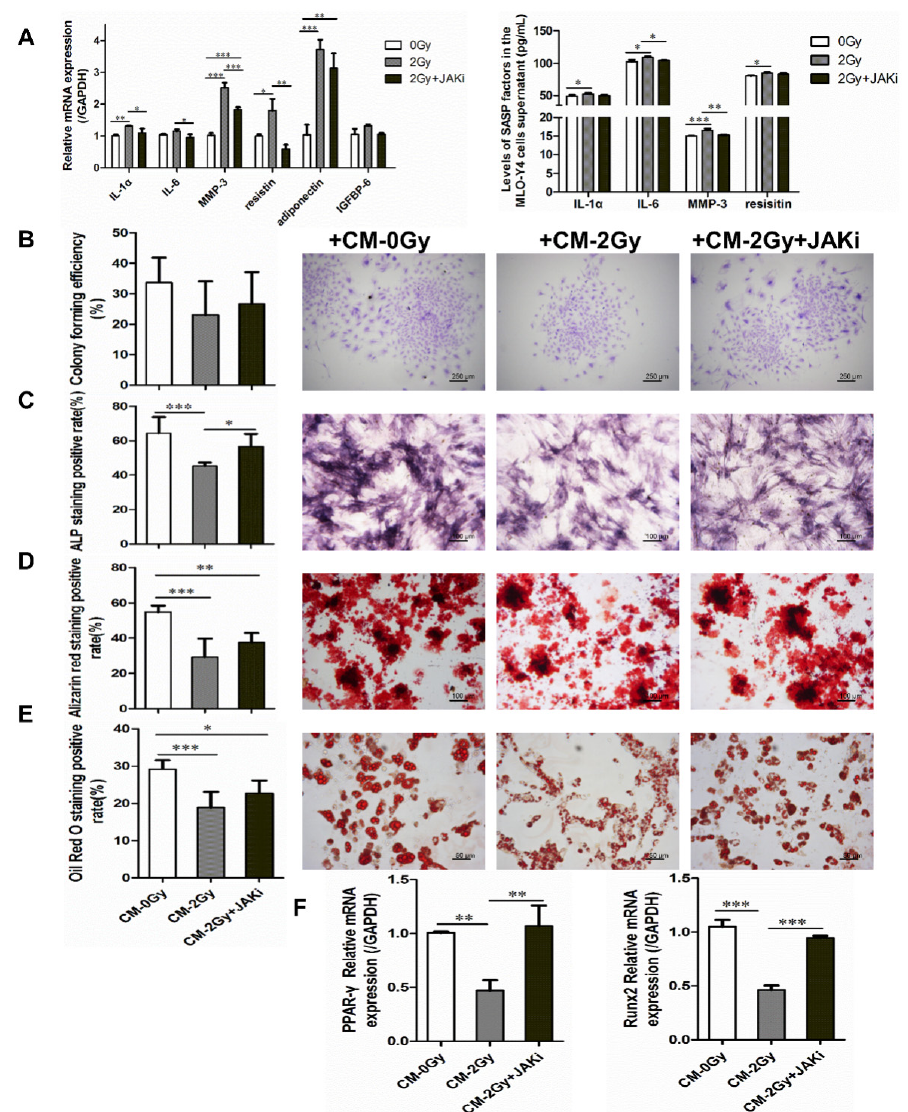
Figure 4. Illustration of the adverse effects of radiation-induced senescent osteocytes on BMSC differentiation via a paracrine pathway. ( A ) JAK1 inhibitor blunting the SASP secretion of radiation-induced senescent MLO-Y4 cells; n = 3. ( B ) Colony- forming capacity was influenced after co-culture with CM- 2 Gy, as observed via crystalline violet staining and colony forma- tion rate calculating. Images were acquired in three randomly obtained regions from three independent experiments; magni- fication = × 40, n = 3. ( C ) Representative images and quantitative analysis of ALP-positive expression; magnification = × 100. ( D ) Representative images and quantitative analysis of mineralized nodule area; magnification = × 100, n = 6. ( E ) Represen- tative images and quantitative analysis of lipid droplet formation; magnification = × 200, n = 6. ( F ) The expression level of osteogenic differentiation-related gene Runx2 and adipogenic differentiation-related gene PPAR- γ in BMSCs co-cultured with CM- 2 Gy or CM- 2 Gy and JAKi. n = 3. Results are expressed as mean ± SD (* p < 0.05; ** p < 0.01; *** p < 0.001 vs. 0